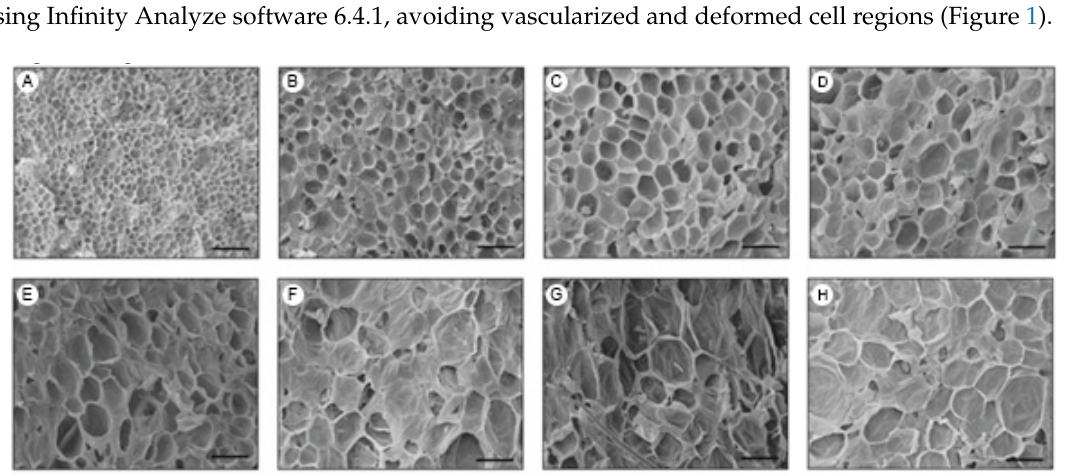
Figure 1. Microphotographs of the scanning electron microscope of the fruit cross-section during the mesocarp development of the peach cultivar Ouro Mel-4: ( A ) 4 August (183.95 GDD), ( B ) 19 August